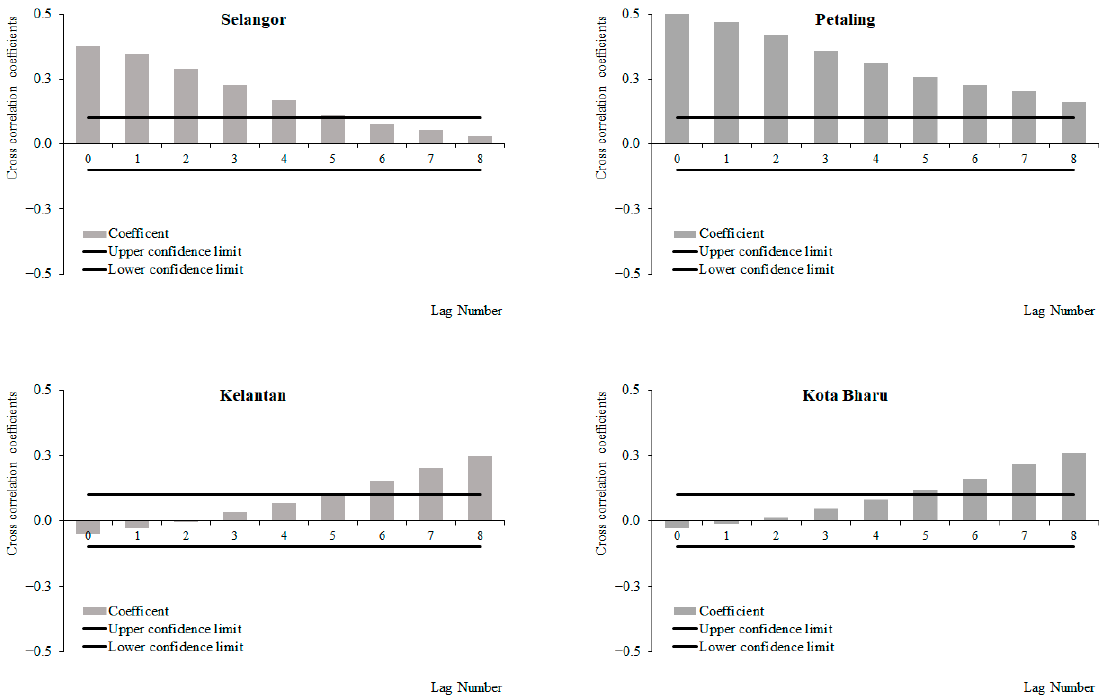
Figure 10. Cross-correlation function between dengue cases and temperature in Selangor, Petaling, Kelantan and Kota Baharu, 2015 to 2019.